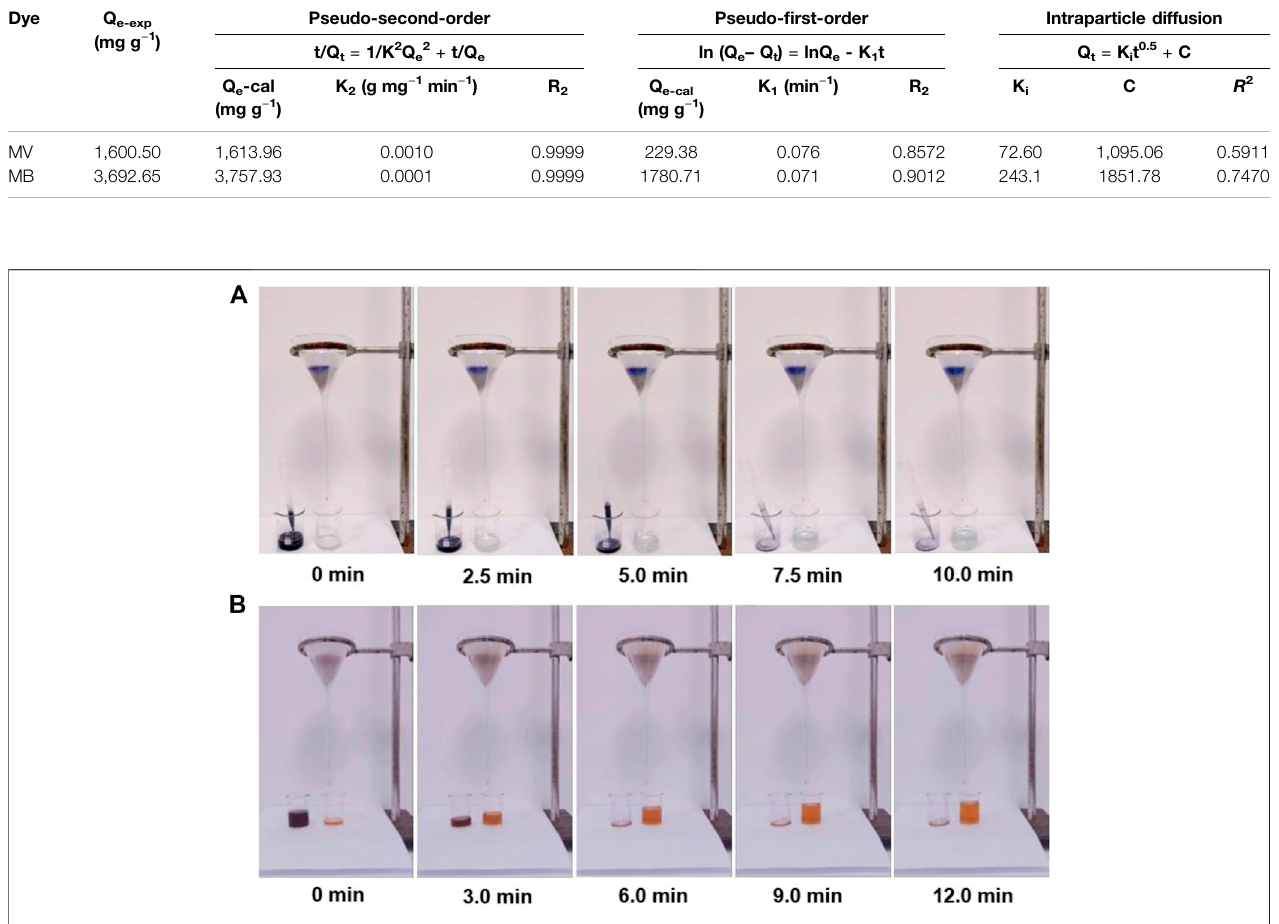
FIGURE 5 | (A) Screenshots of adsorption videos based on the addition of 15 ml of MB (1,500 mg L − 1 ) solution to passthrough an PFPCS column. (B) Screenshots of adsorption videos based on the addition of 20 ml of MV/MO (500 mg L − 1 ) solution to pass through an PFPCS column. 100 mg of dried PFPCS was utilized to construct the